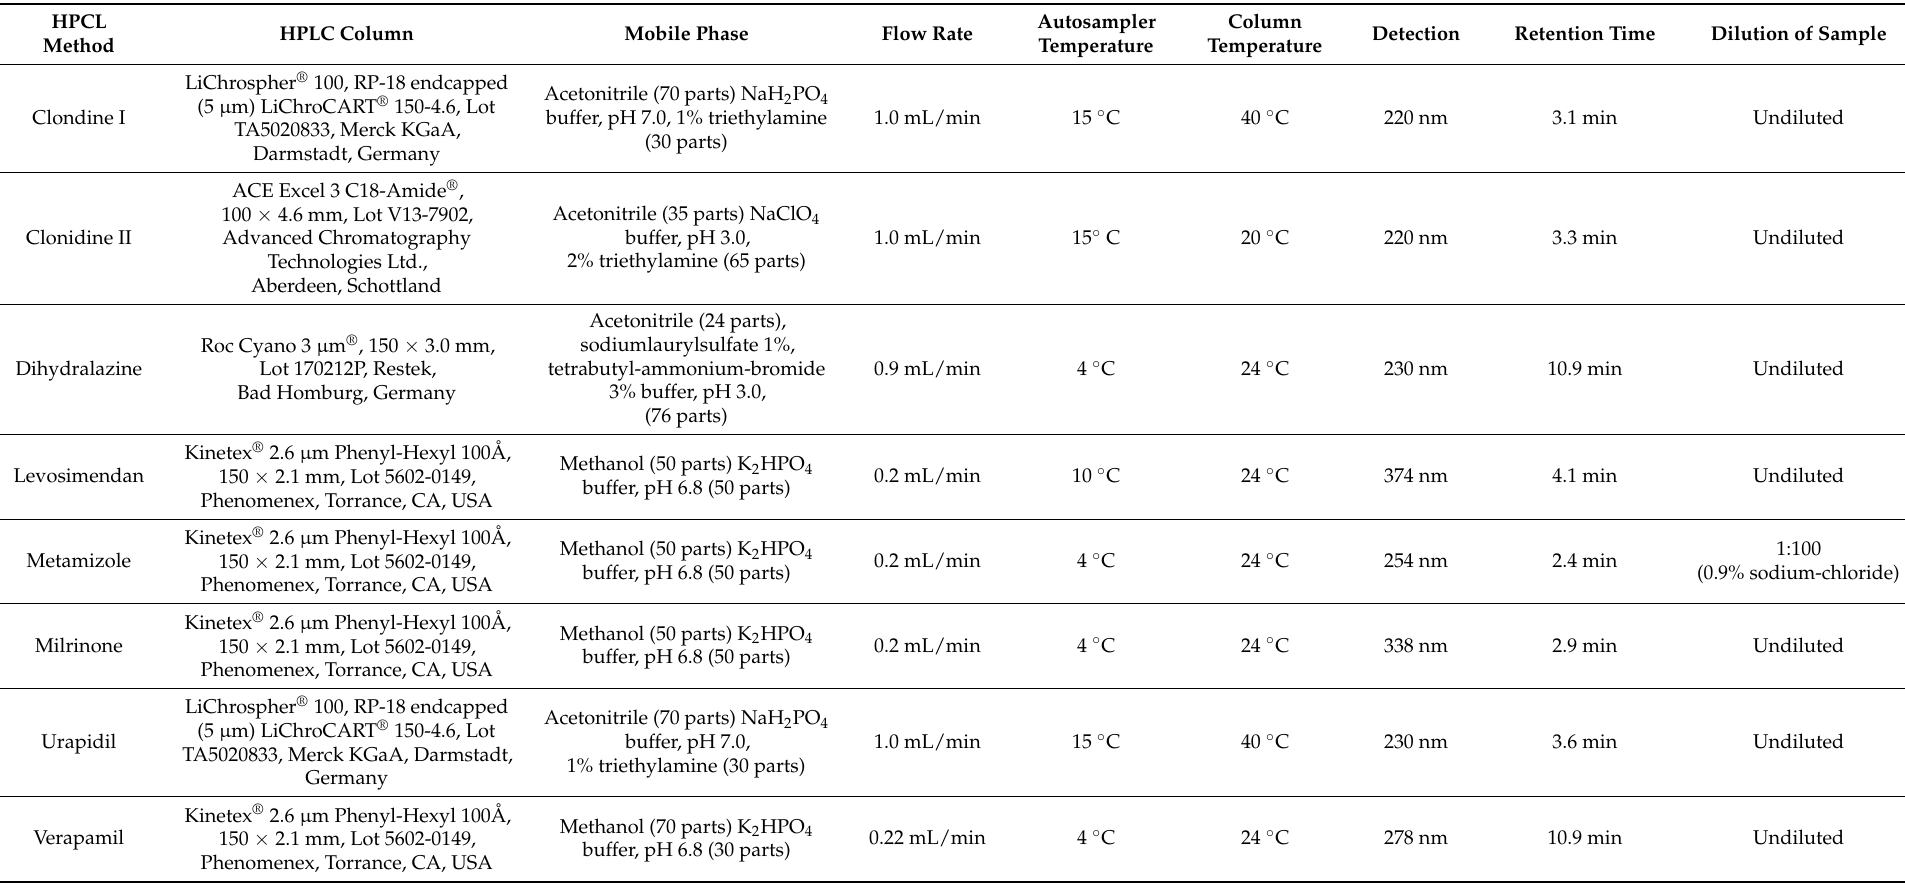
Table A2. HPLC applications: two separation methods for the quantification of clonidine hydrochloride were developed. Method I was used to separate clonidine hydrochloride from all combination partners of the study, except for metamizole. Method II was used to separate clonidine hydrochloride from a degradation product of metamizole